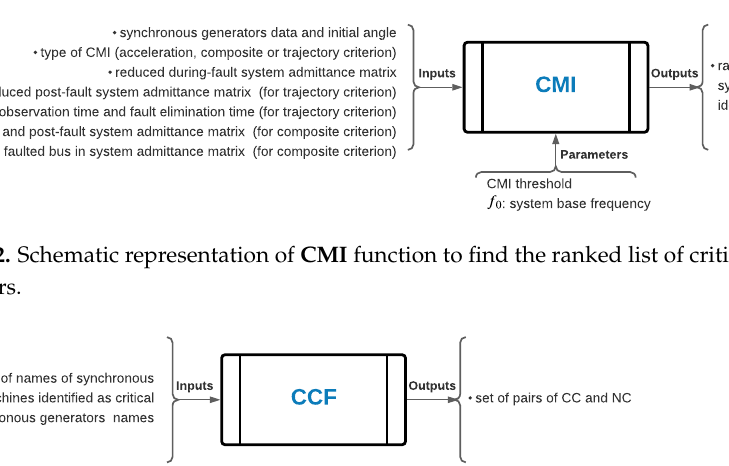
Figure 13. Schematic representation of CCF function to form the candidate CCs and